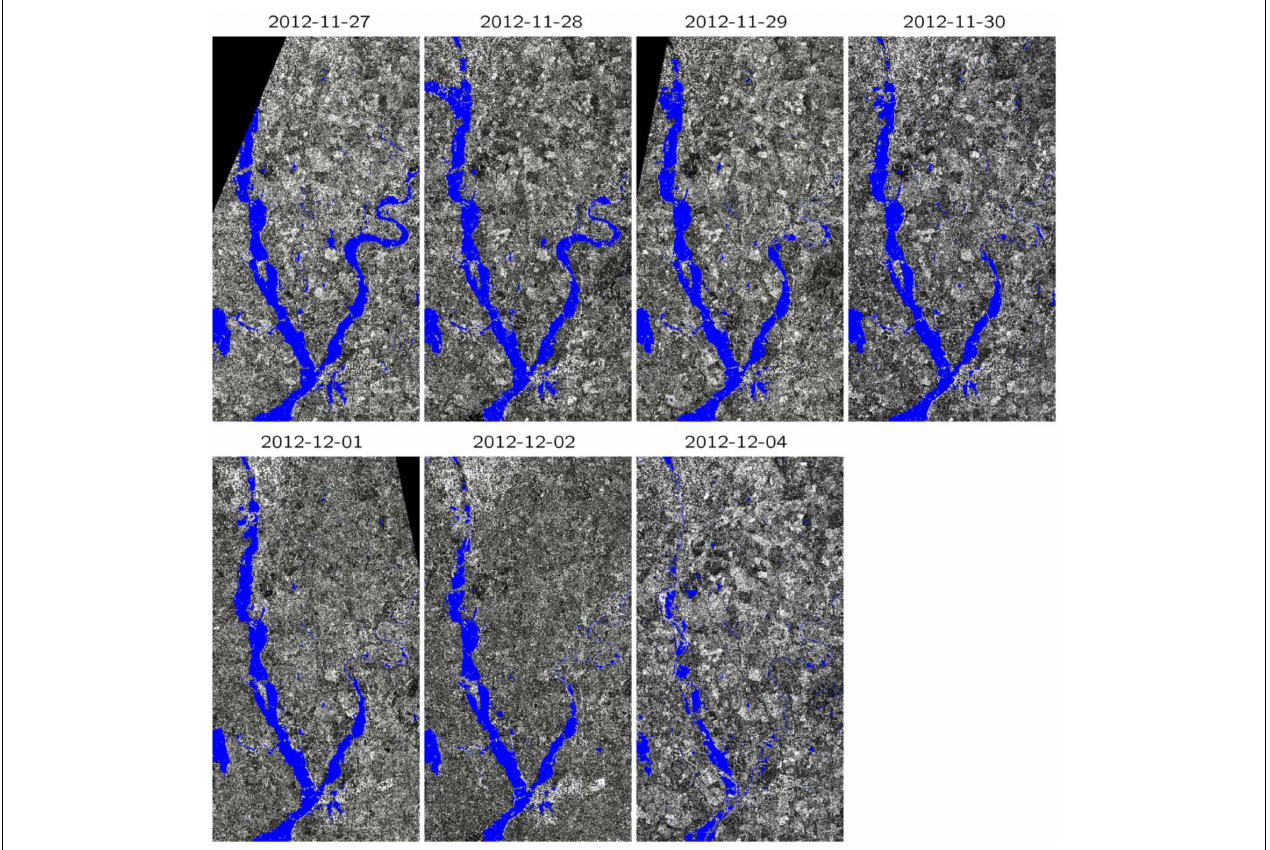
FIGURE 2 | Flood extents (blue) for the event of November 2012, overlain on SAR imagery of the flooded domain of Figure 1 (©CSK) (after Garcia-Pintado et al., 2015).